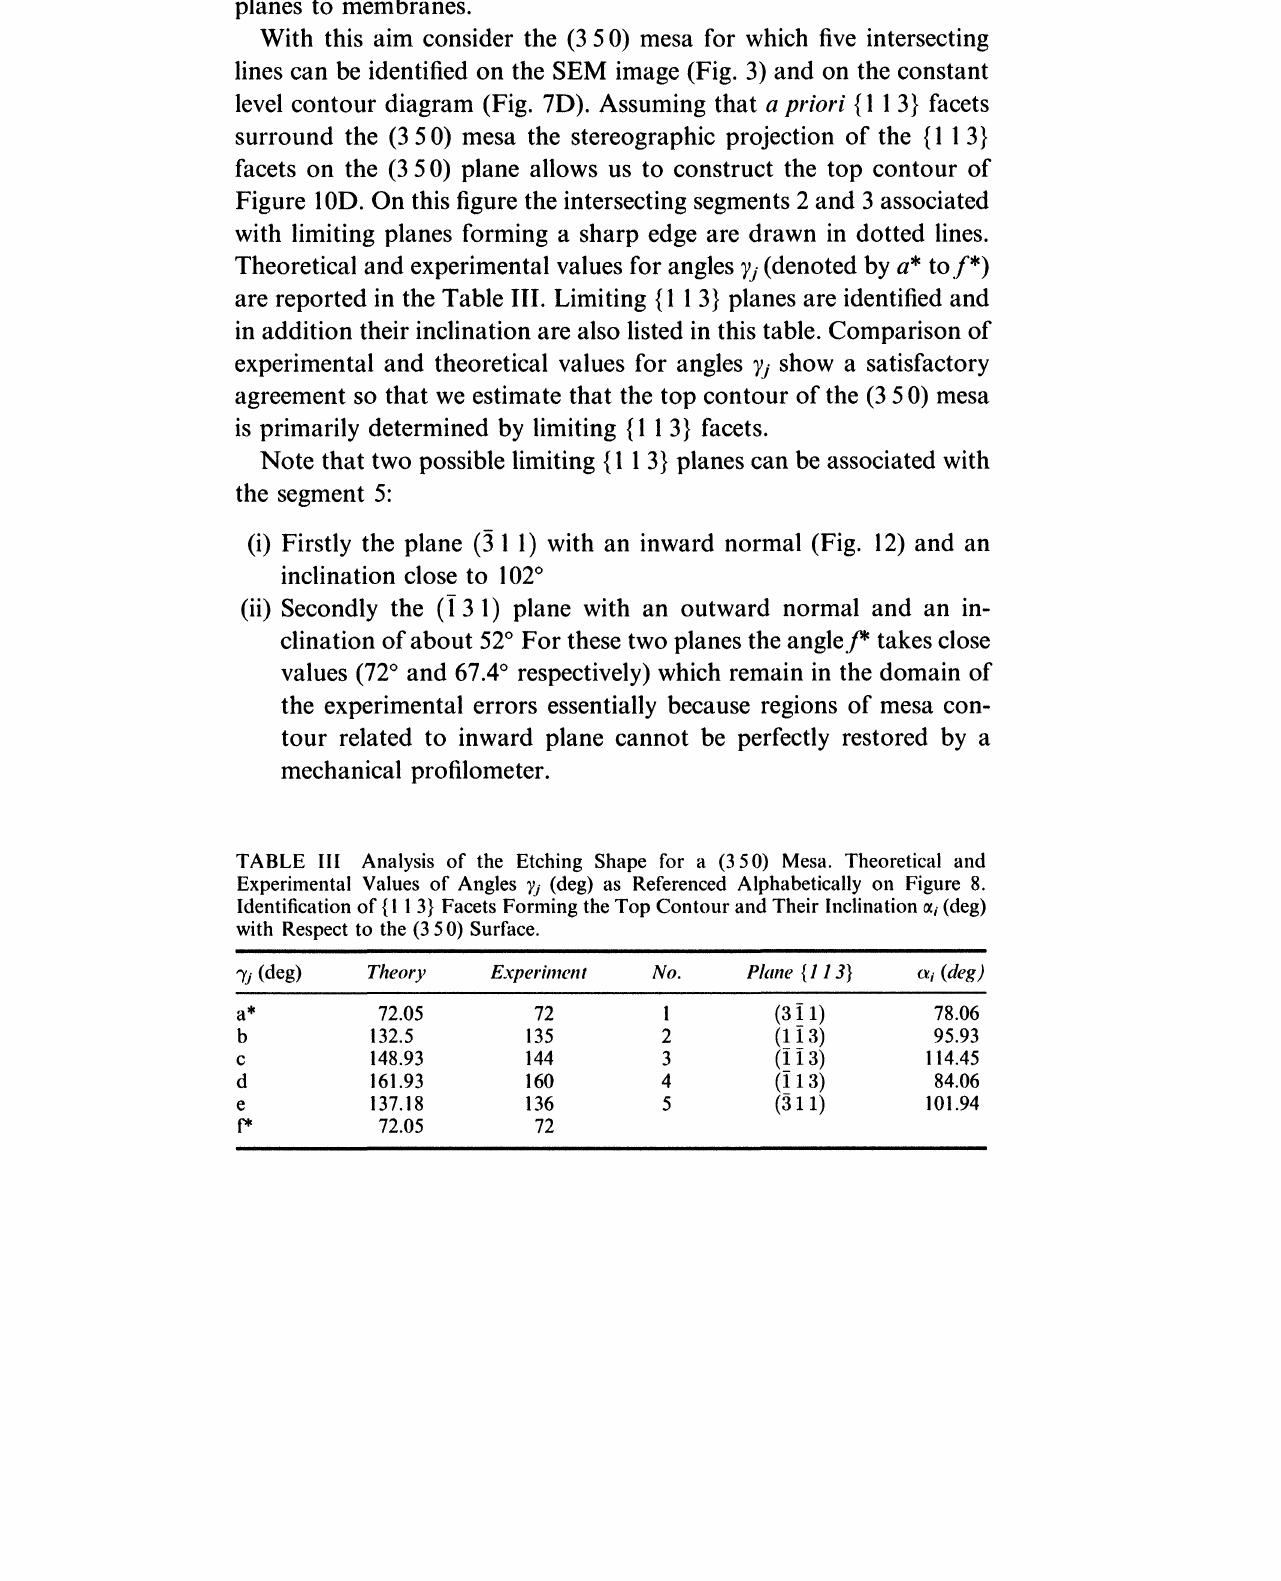
TABLE III Analysis of the Etching Shape for a (350) Mesa. Theoretical and Experimental Values of Angles V (deg) as Referenced Alphabetically on Figure 8. Identification of 3} Facets Forming the Top Contour and Their Inclination ti (deg) with Respect to the (3 5 0) Surface. ,’),j